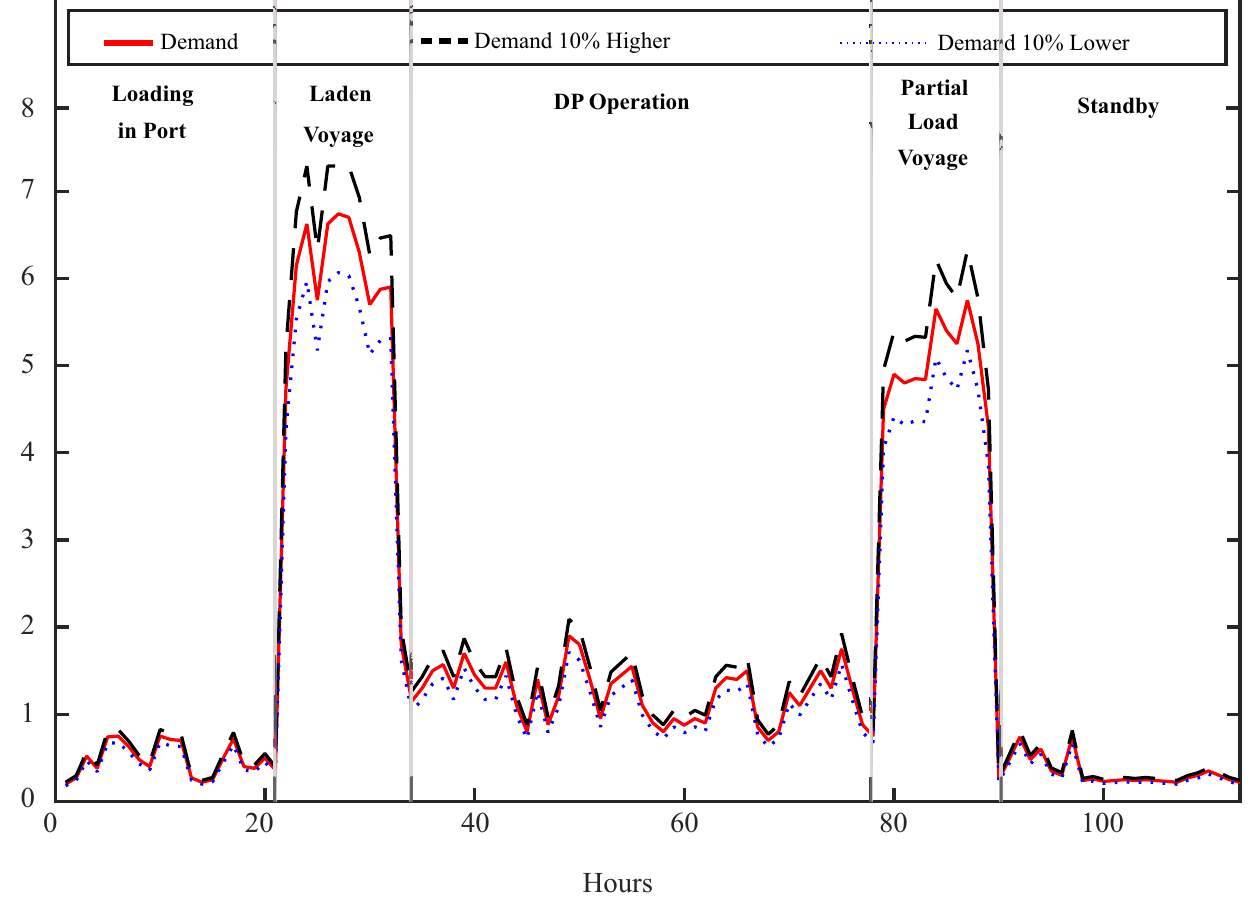
Figure 2. Standard PSV power demand considering different parts of the mission pursued (red curve) and variations considered for the sensitivity analysis (+10% original power demand—dashed black line, − 10% original power demand—dotted blue